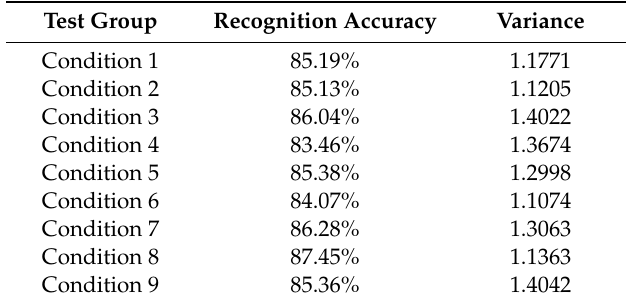
Table 7. The recognition accuracy under di ff erent operating conditions using WPD. Test Group